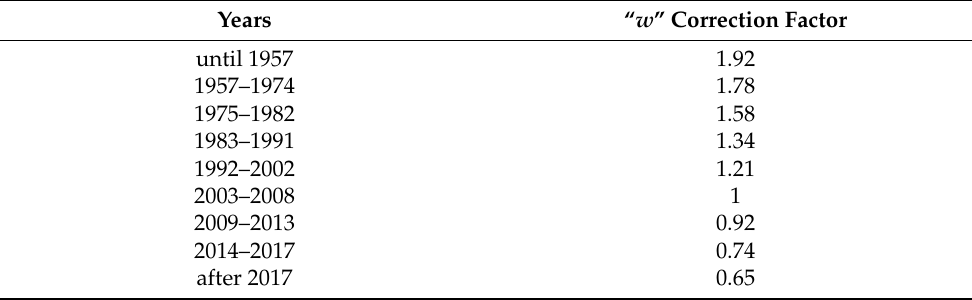
Table 3. Values of the correction factor depending on the age of the building.